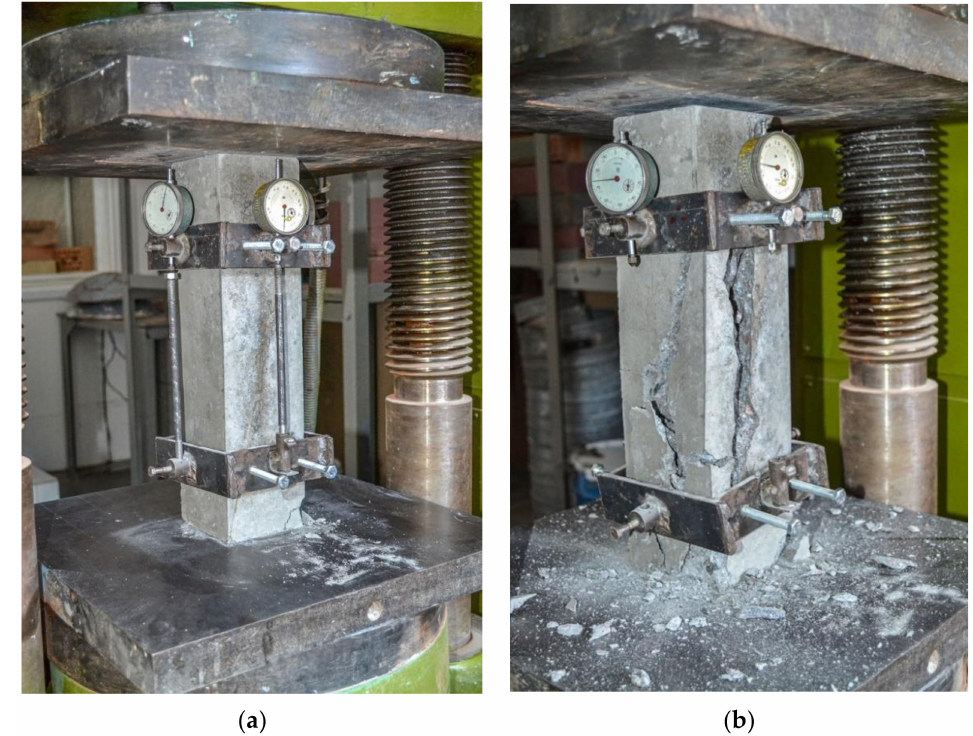
Figure 3. Photo of determining the deformation of the prism sample under axial compression ( a ); destroyed sample ( b